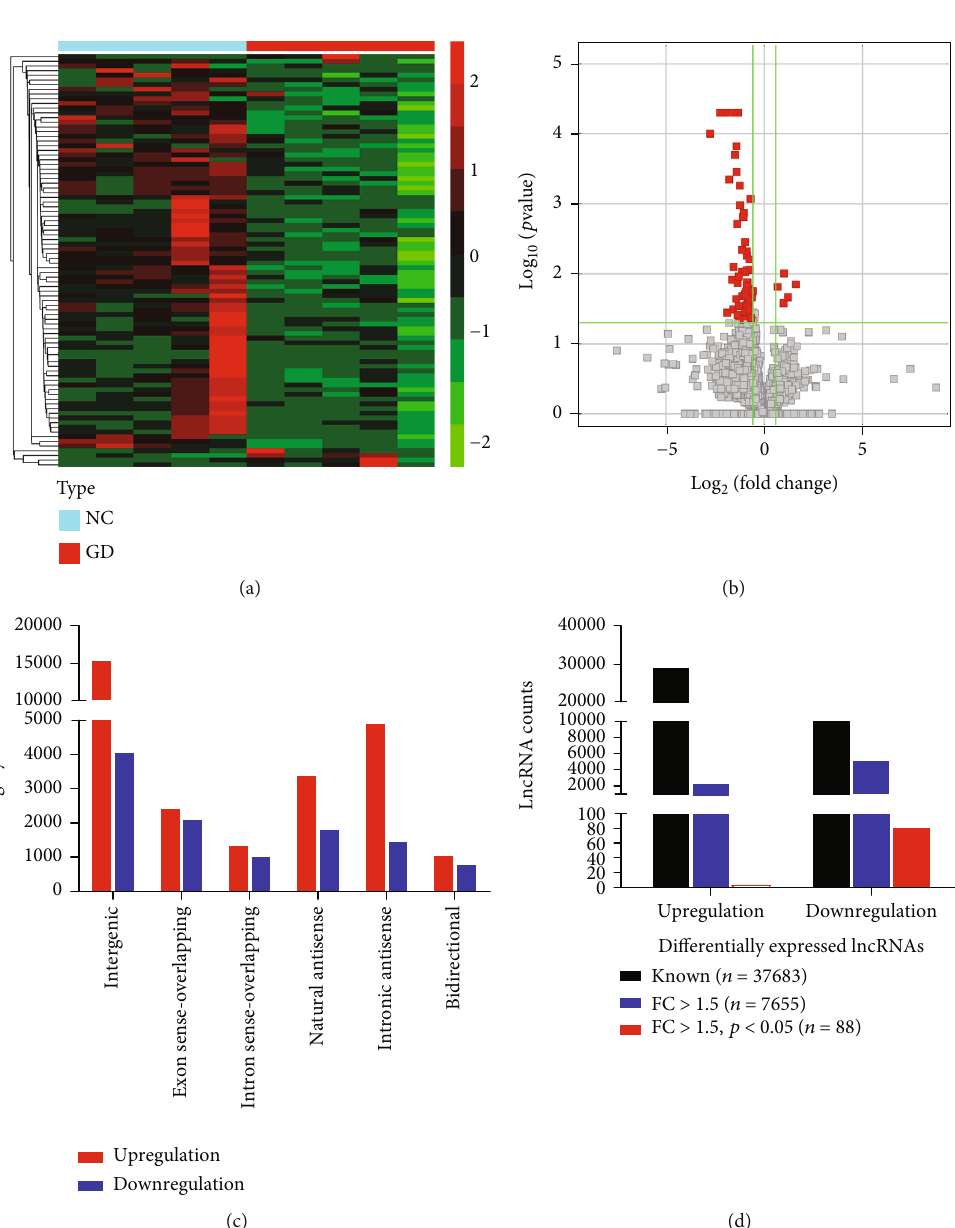
TRAb ( r = − 0 : 5780 ; p = 0 : 0020 ) (Figure 6(a)), but not with the serum concentrations of TgAb ( r = − 0 : 2329 ; p = 0 : 2521 ) (Figure 6(b)) and TPOAb ( r = − 0 : 3242 ; p = 0 : 1062 )